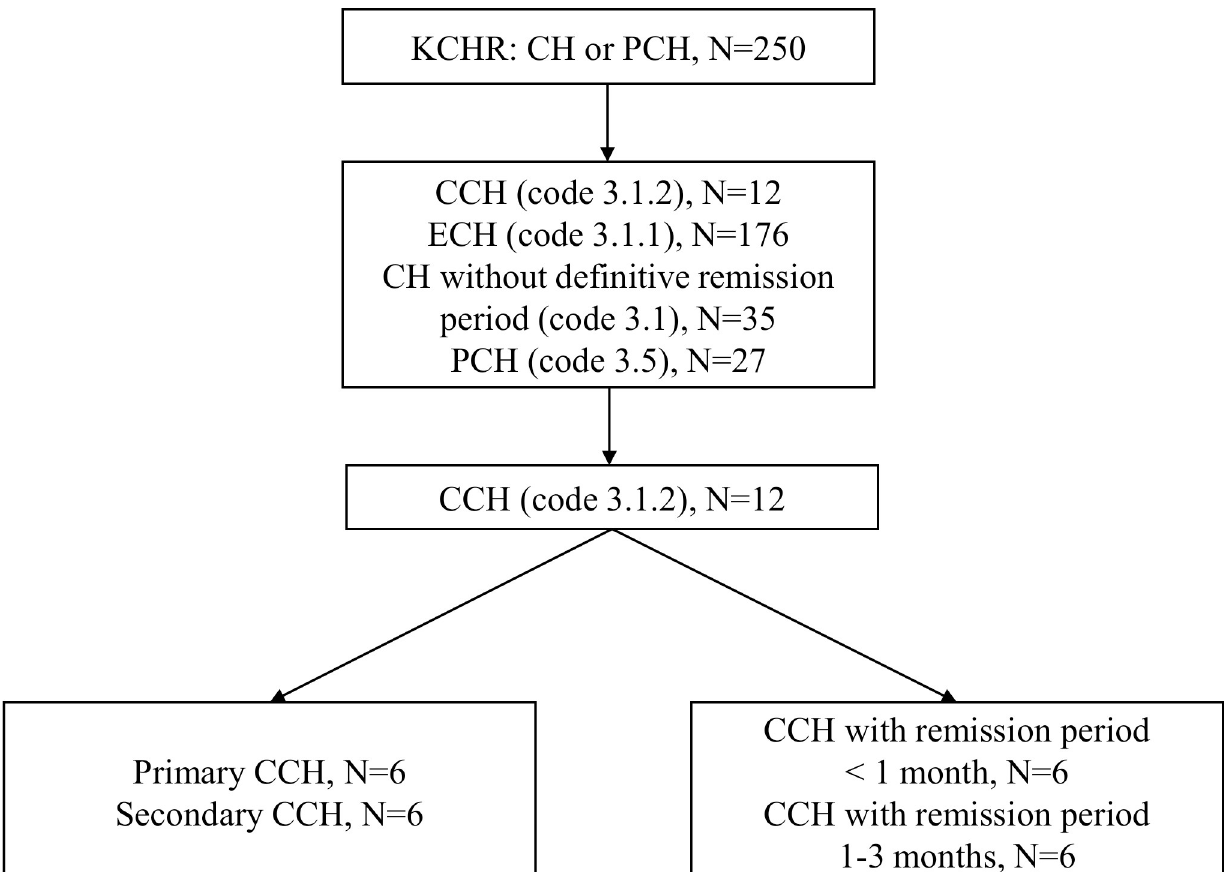
Fig 1. Flow chart of study participants. KCHR: Korean Cluster Headache Registry, CH: cluster headache; CCH: chronic cluster headache; ECH: episodic cluster headache; PCH: probable cluster headache.